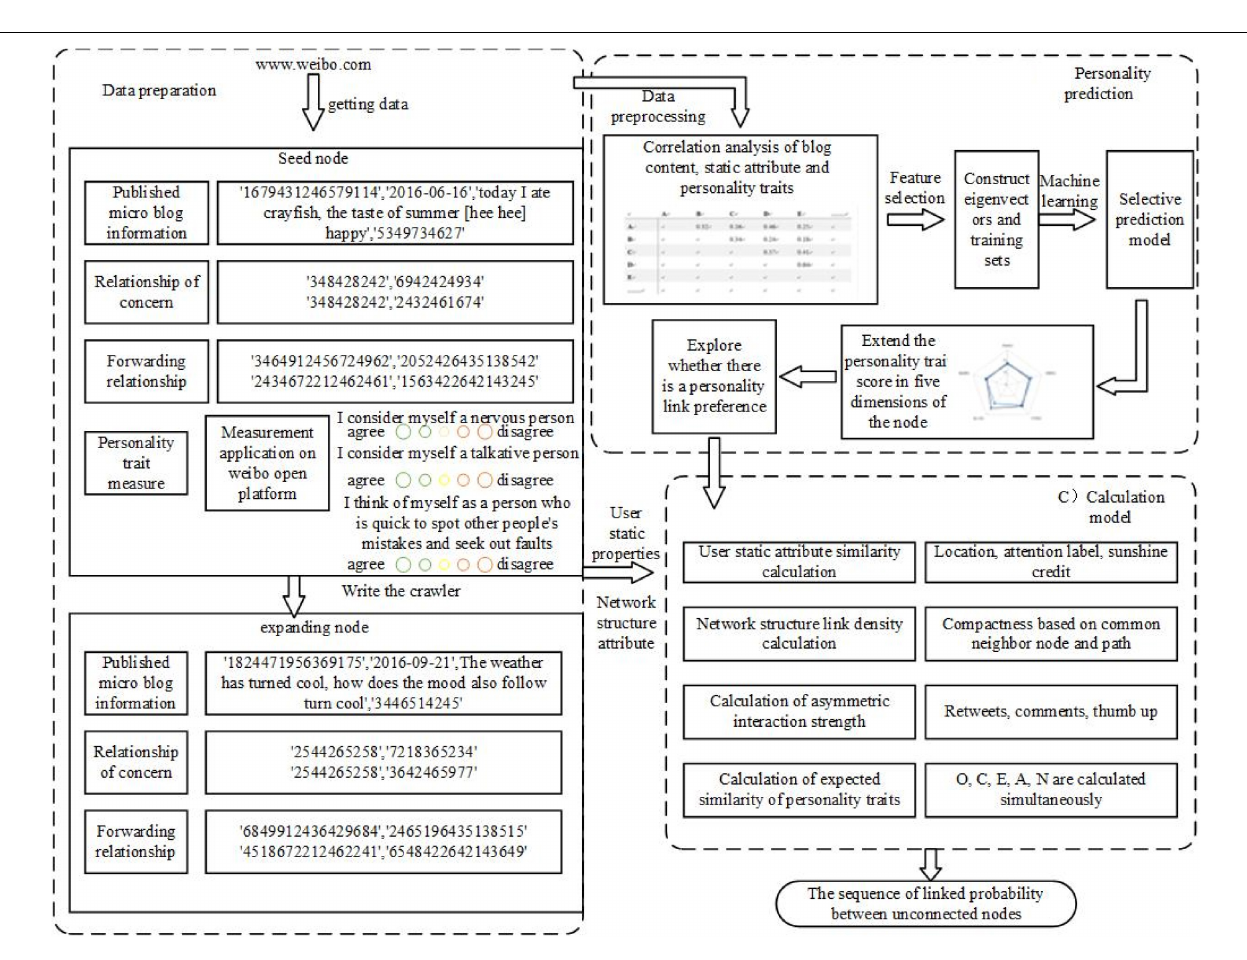
FIGURE 2 | A link prediction model framework of four-dimensional social